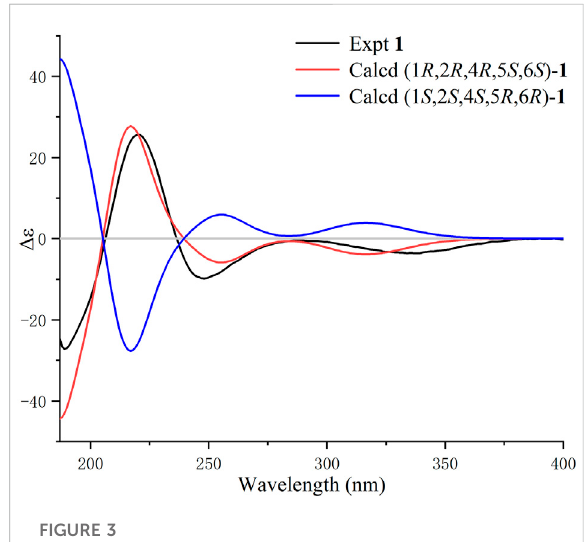
FIGURE 3 Calculated and experimental ECD spectra of 1 in